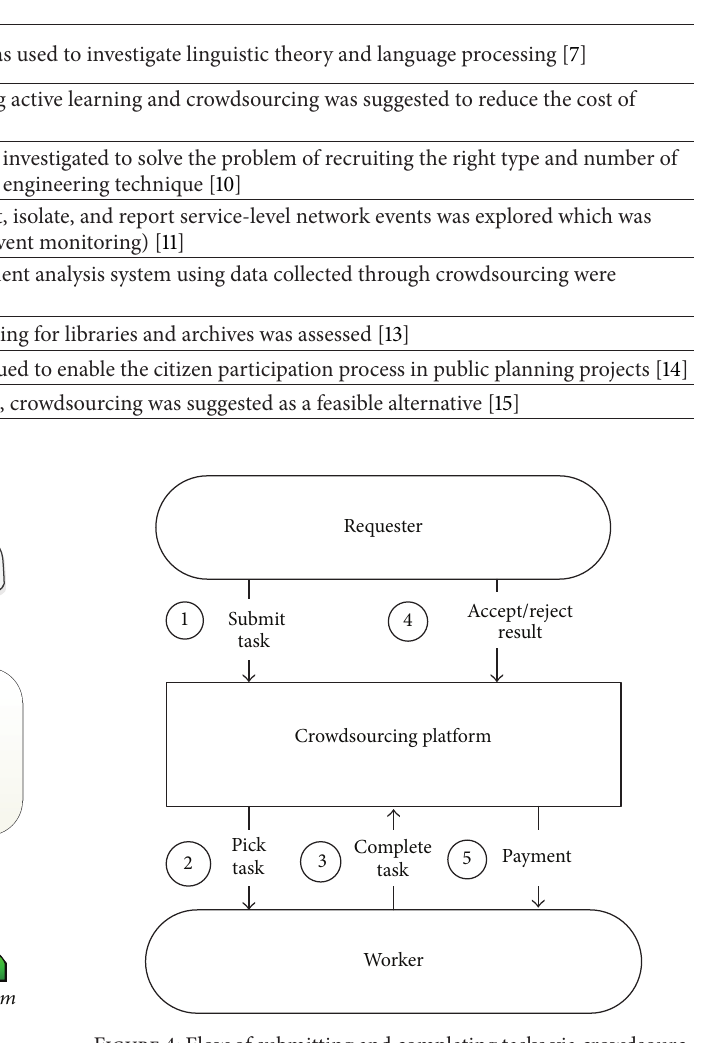
Figure 3: Crowdsourcing scheme. Figure 4: Flow of submitting and completing tasks via crowdsourc-